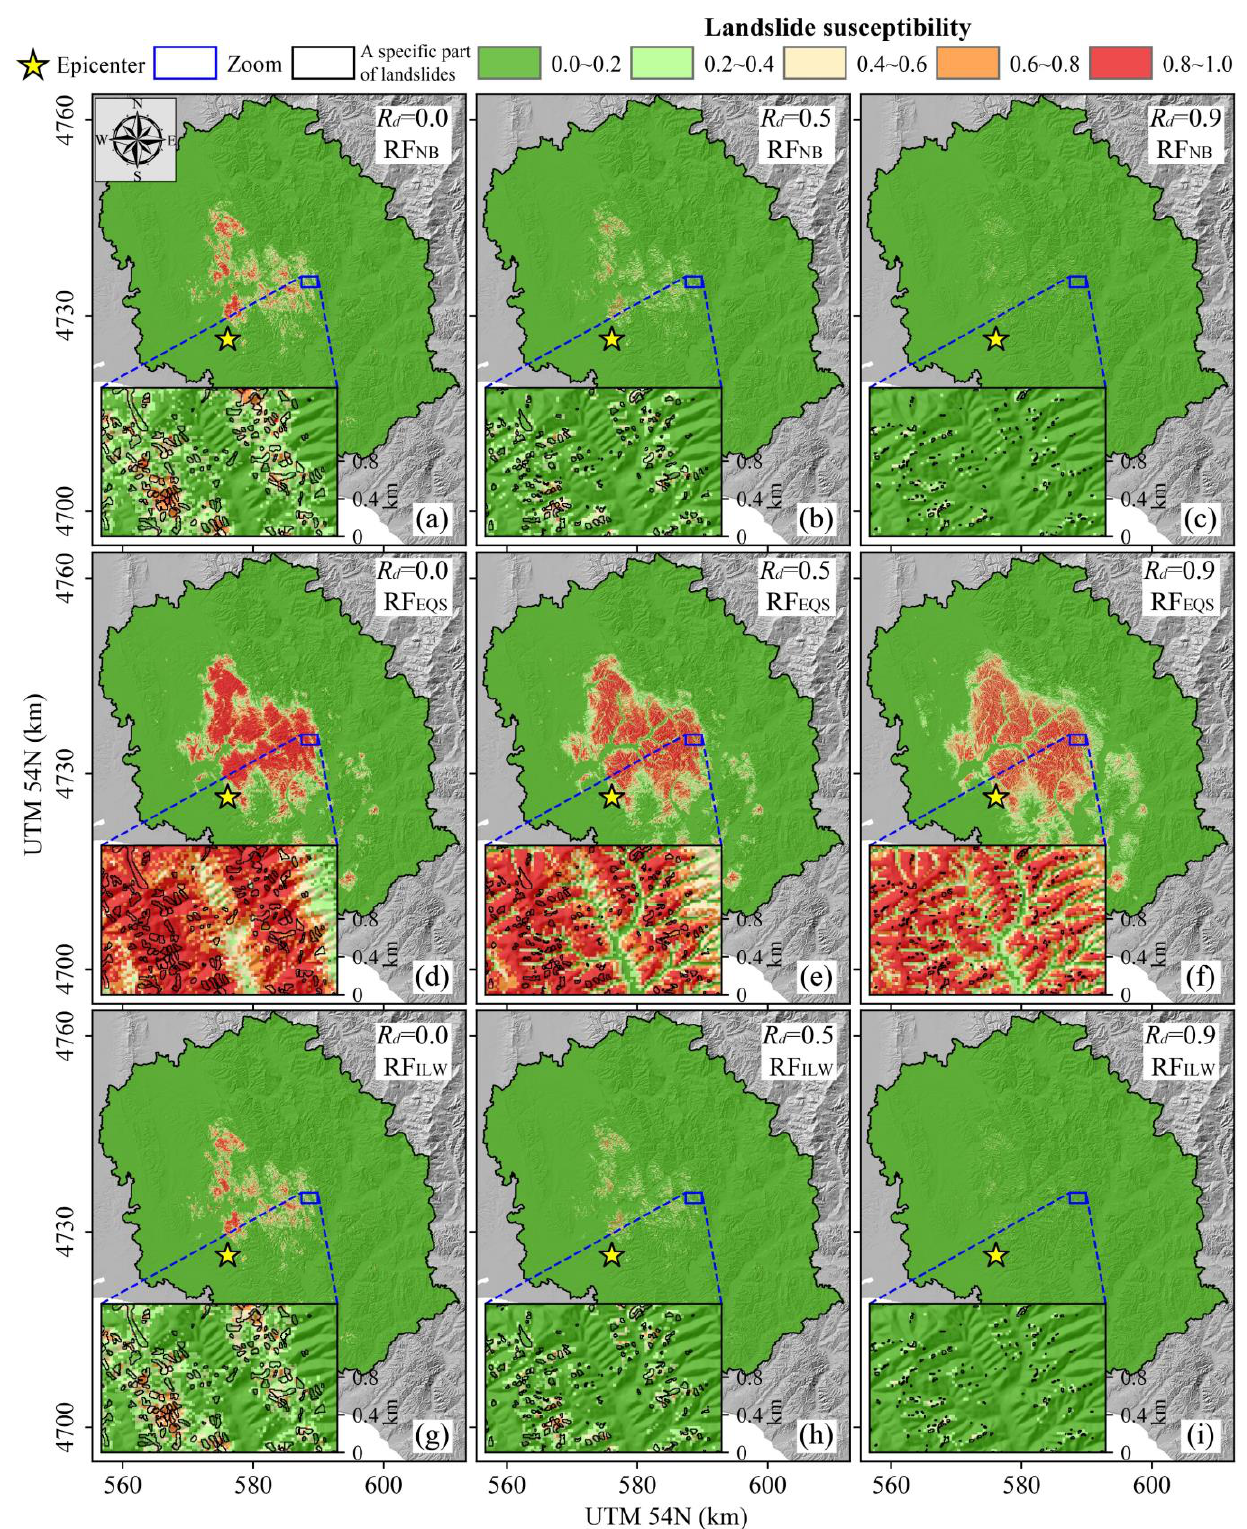
Figure 7. Prediction of the susceptibilities of various landslide parts with combinations of the RF algorithm with different class balancing methods: ( a – c ) RF NB , ( d – f ) RF EQS , ( g – i ) RF ILW . As R d increases, the part of the landslide that the model seeks to predict (the black polygon) is reduced from the entire landslide to the landslide scarp.